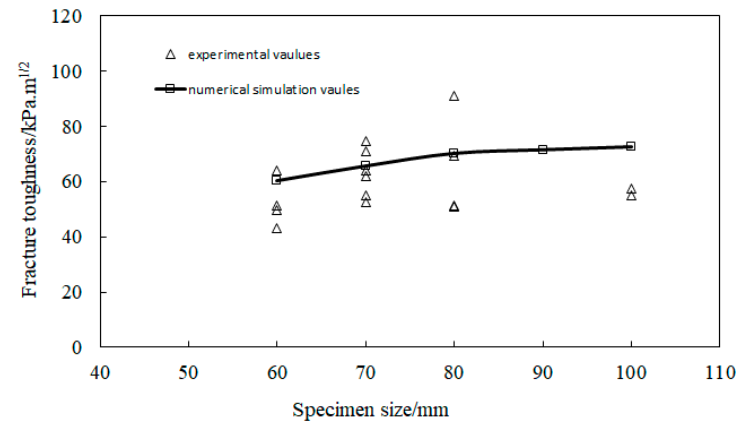
Figure 5. Contrast diagram of simulated values and experimental values.